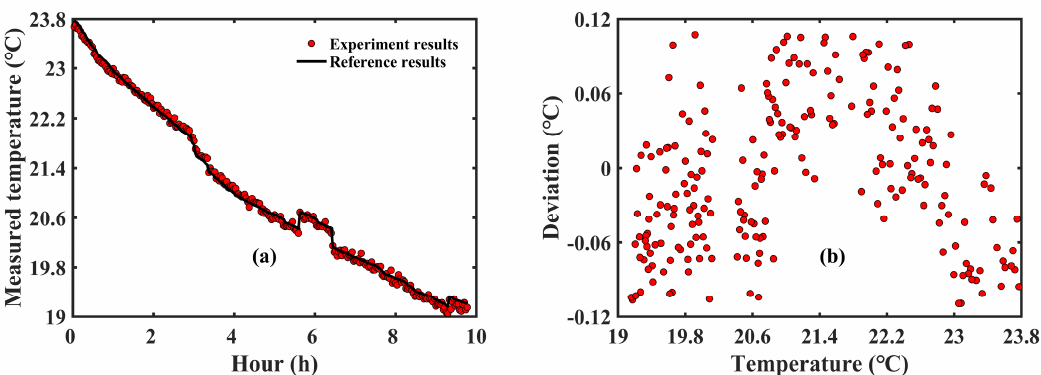
Appl. Sci. 2019 , 9 , x FOR PEER REVIEW 9 of 13 Figure 7. Long-term measurement of water temperature from 10:00 p.m. to 8:00 a.m. ( a ) Results obtained using temperature sensor and our method. Red solid circle: our method results, black solid line: the temperature sensor results; ( b ) the di ff erence between our method and the temperature sensor.